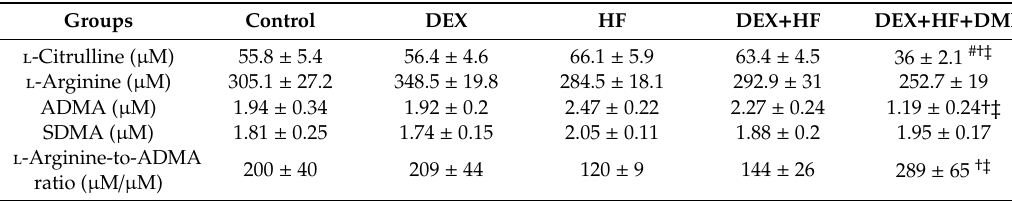
Table 2. Plasma levels of NO-related parameters.